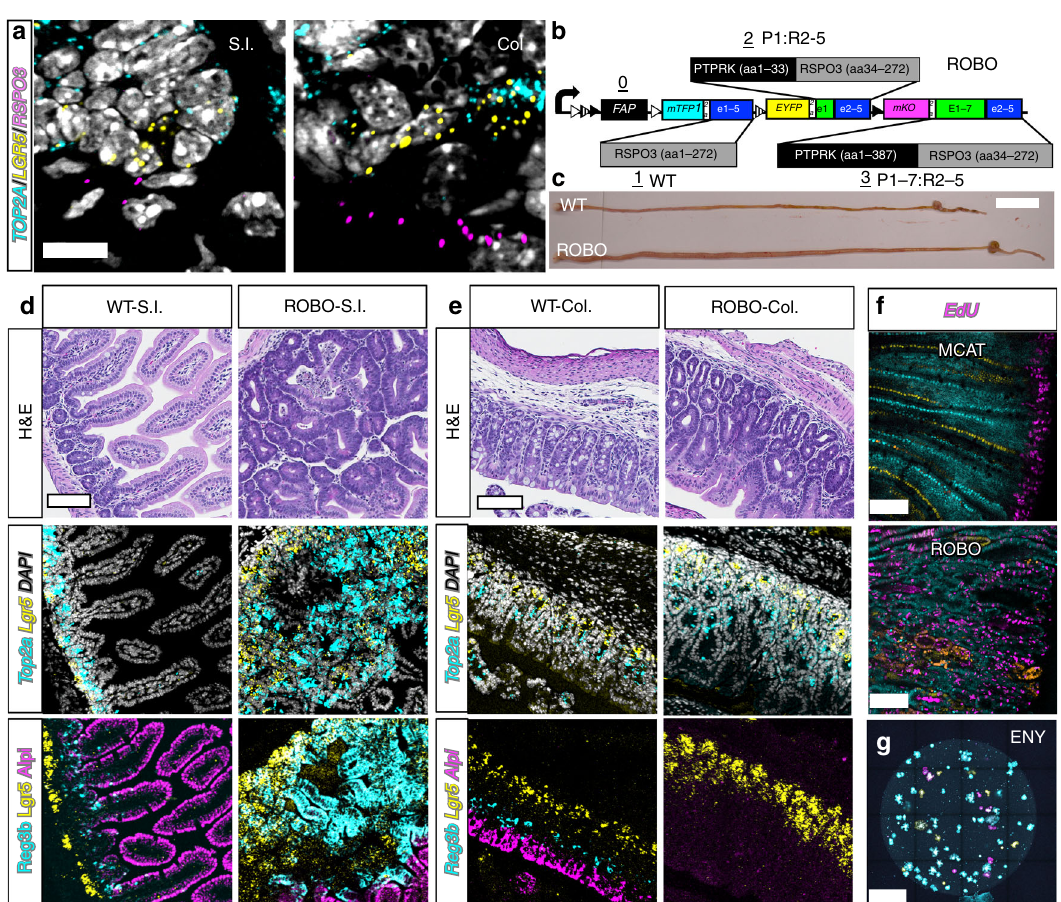
Fig. 5 Ectopic expansion of the intestinal stem cell compartment by expression of oncogenic RSPO3. a Multiprobe RNA FISH and confocal microscopy for Top2a (cyan), Lgr5 (yellow), and Rspo3 (magenta) in paraf fi n-embedded sections of the small intestine (SI) and colon (Col). b ROBO VilCr e mice expressing oncogenic human RSPO3. Position 0: control and membrane-targeted FAP-Mars1 , Position 1: mTFP1 (cyan) coexpressed with 3×FLAG-RSPO3, EYFP (yellow) coexpressed with V5-PTPRK e1 :RSPO3 e2 – 5 , and Position 3 : mKO (magenta) coexpressed with 3×HA-PTPRK e1 – 7 :RSPO3 e2 – 5 (see also Supplementary Fig. 7). c Gross examination of the ROBO VilCre mice and gastrointestinal tracts at PND16 compared with WT littermate controls. WT and ROBO d small intestines (SI) and e colons (Col) were paraf fi n embedded and sectioned for H&E pathology and coregistry of indicated cell type markers by multiprobe RNA FISH. Images are insets from whole-slide imaged Swiss rolls (see Supplementary Figs. 8 – 13). f MCAT VilCre and ROBO VilCre mice were injected with EdU (magenta) and coimaged for each lineage reporter by confocal microscopy (mTFP1: cyan, EYFP: yellow, mKO: orange). g ROBO VilCre organoids can grow without exogenous RSPO3 (ENY) and were imaged by confocal microscopy for each lineage reporter. Scale bars = 10 µ m in a , 2 cm in c , 100 µ m in d, e , 50 µ m in f , and 1 mm in g . Source data are provided as a “ Source Data fi le ”